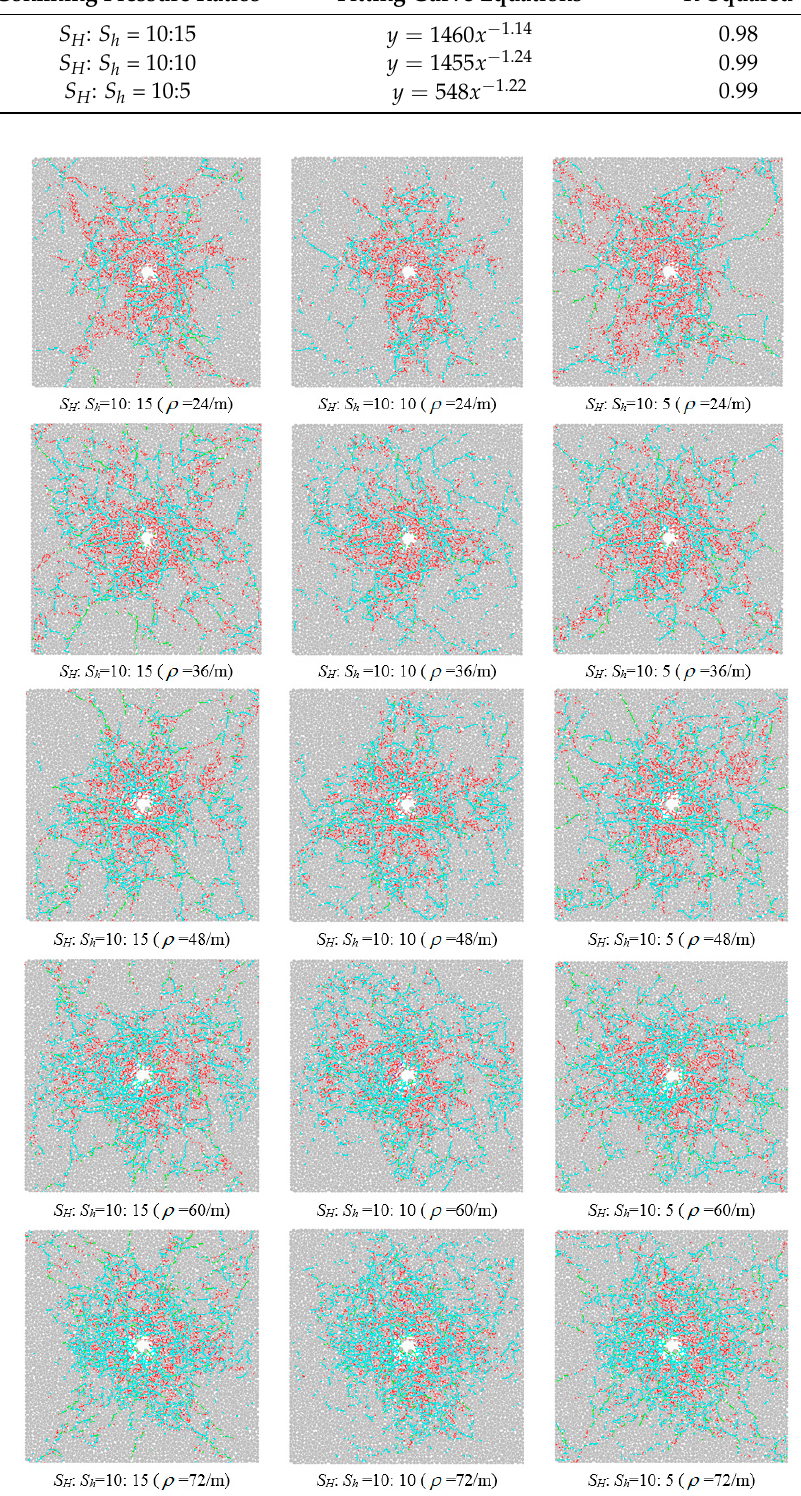
Table 5. Fitting curve equations of beakdown pressure under different confining pressure ratios. Confining Pressure Ratios Fitting Curve Equations